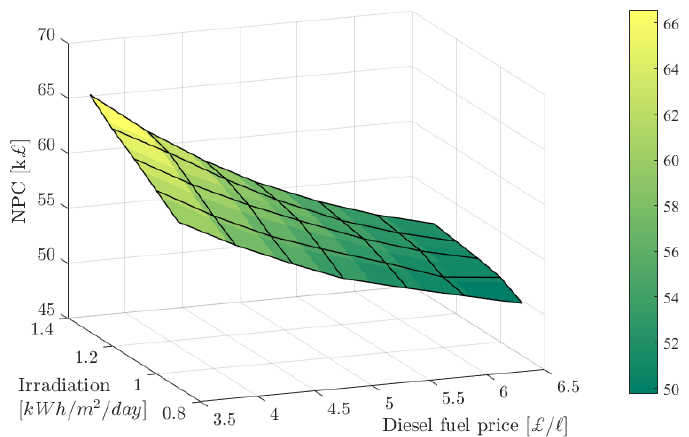
Figure 9. Sensitivity analysis regarding diesel prices and solar